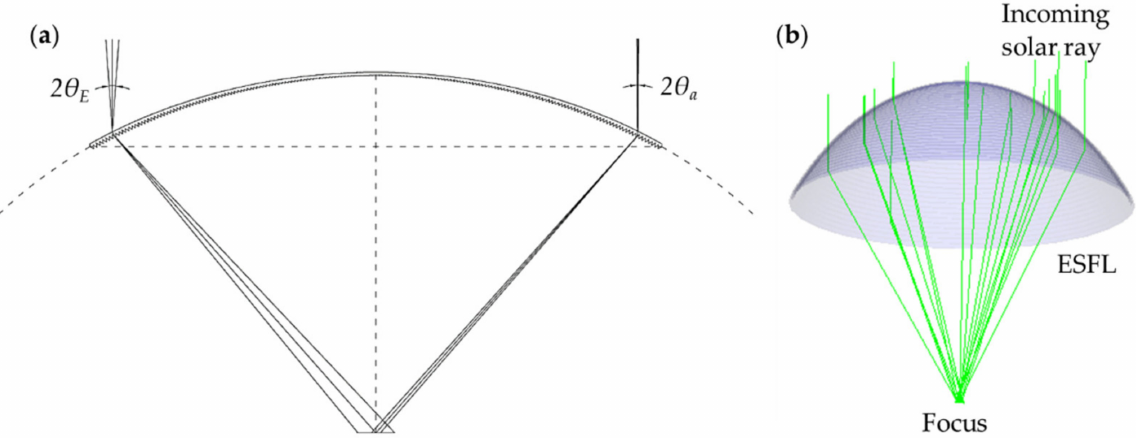
Figure 1. ( a ) Cross-sectional representation of an elliptical-shaped Fresnel lens (ESFL). 2 θ a represents the subtended angle of the Sun to the Earth and 2 θ E the solar–terrestrial angle after the passage of the solar rays through the atmosphere. ( b ) 3D representation of the